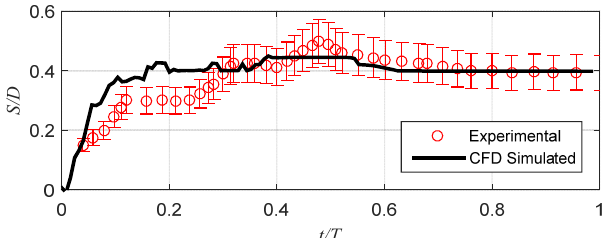
Figure 5. Comparison of scour depth development at the front corner position between CFD simu- lated and experimental measured results.